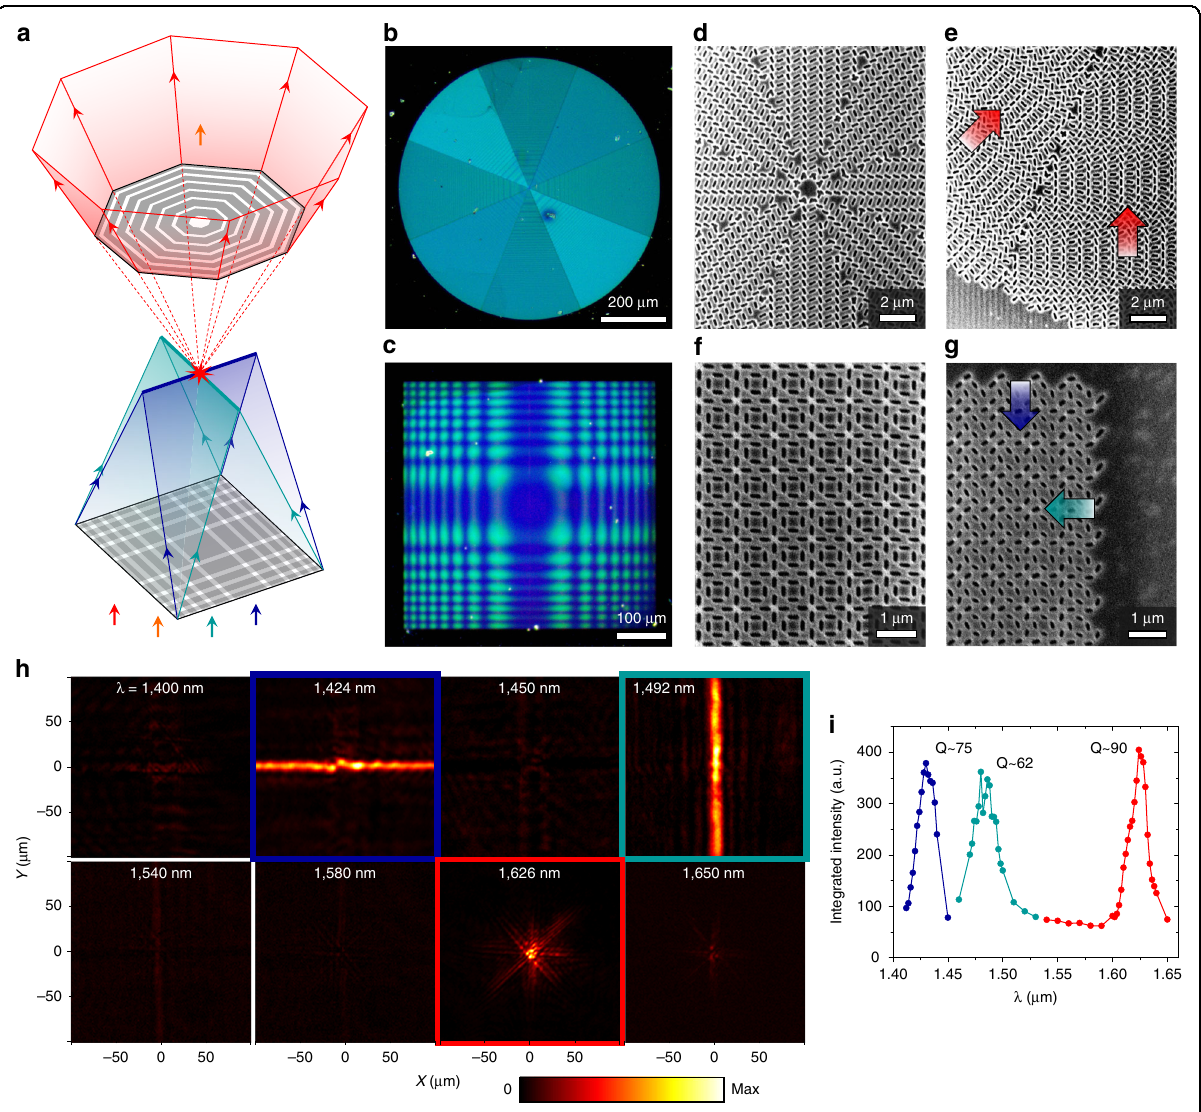
Fig. 4 Experimental results of a three-function doublet. a Schematic illustrating the operation of the three-function doublet with a single- function quasi-radial lens with NA = 0.4 as a diverging element and a dual-function metalens (two orthogonal cylindrical lenses, both with NA ~ 0.1) as a converging element. Dark fi eld optical microscope images of the diverging ( b ) and converging ( c ) devices. SEM images of the diverging device at its center ( d ) and edge ( e ). SEM images of the converging device at its center ( f ) and edge ( g ). Arrows indicate phase gradient direction. h Measured transverse intensity distributions of handedness-converted light of the doublet at the shared focal plane. i Estimated Q-factors for the three lensing functions by integrating the optical intensity over the focal features (focal lines or focal spot) as a function of wavelength (Supplementary Section 10). Device dimensions are detailed in Table